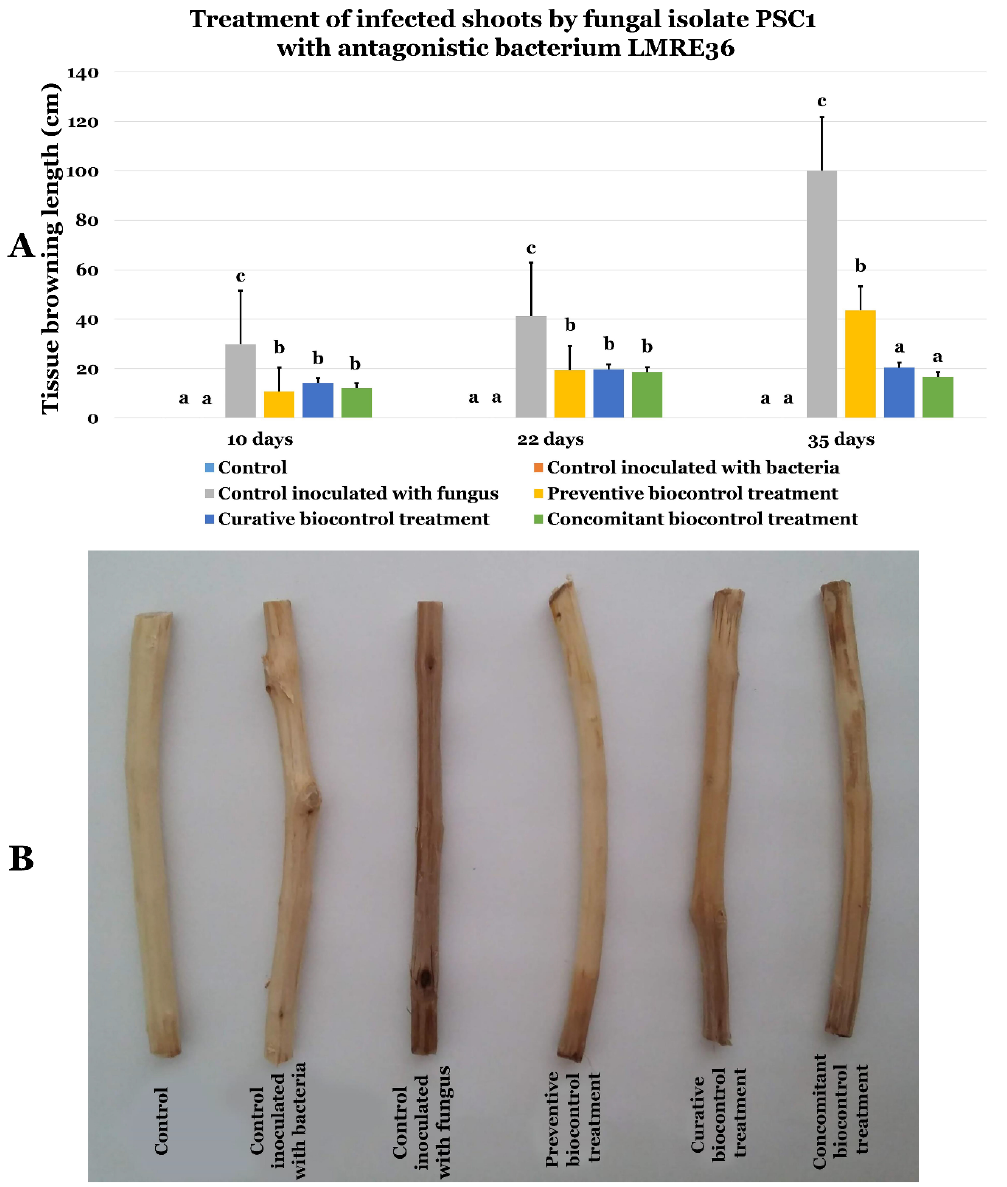
Figure 15. ( A ) E ff ects of LMRE 36 bacterial isolate on Fusarium solani strain PSC1 on olive tree shoots rot severity as compared to controls. ( B ) E ff ect of preventive, concomitant, and curative biocontrol treatment on olive tree shoots at 10, 22 and 35-days post-inoculation with Fusarium solani strain PSC1. Data presents mean ± standard error. Bars labelled with di ff erent letters are significantly di ff erent among the treatments at p < 0.05 using Tukey’s HSD